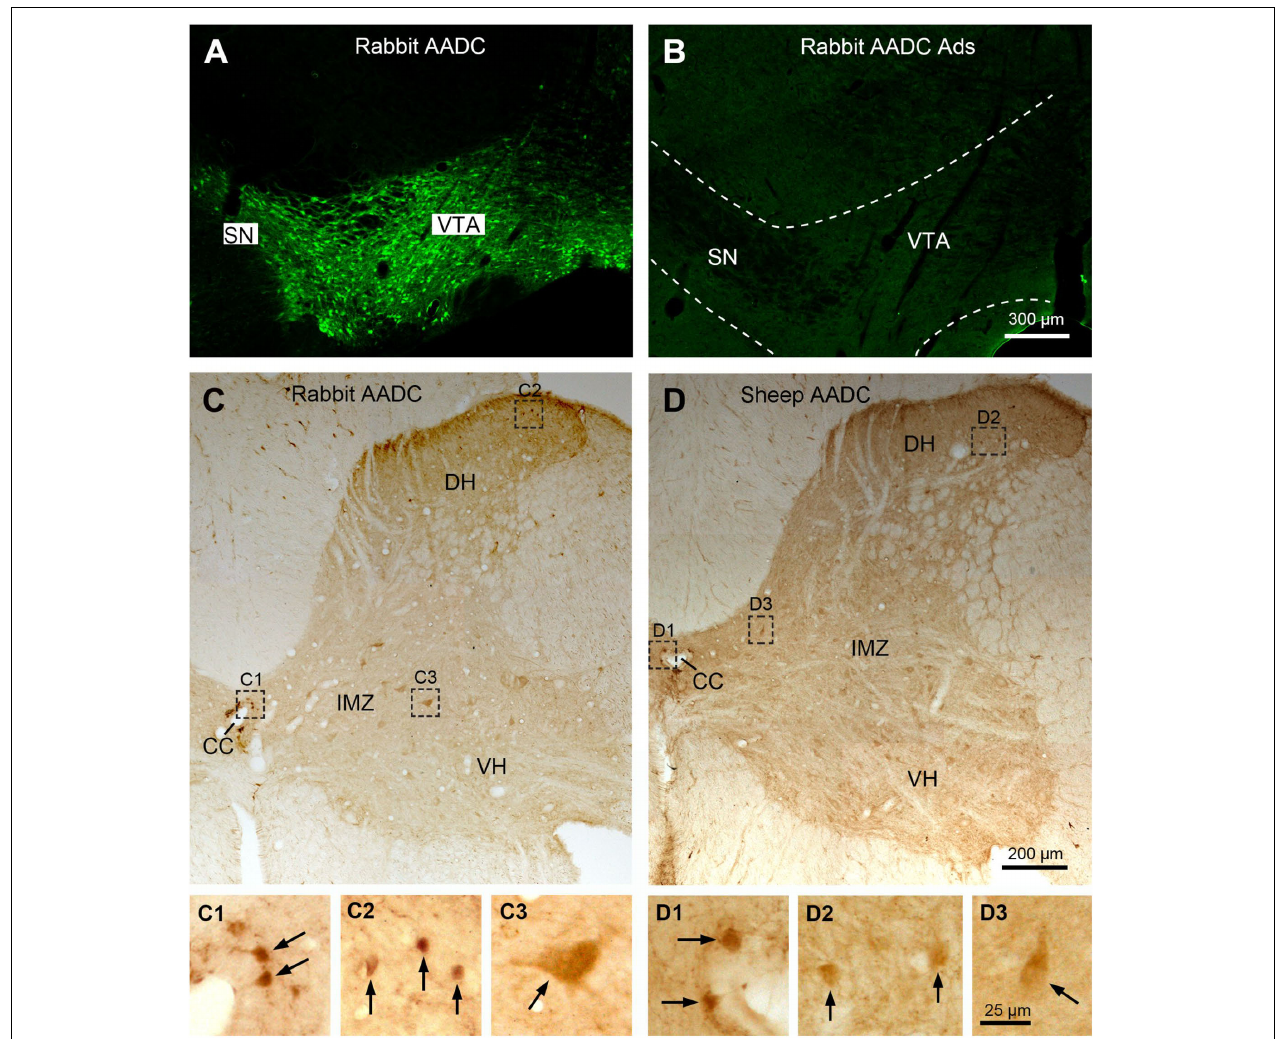
FIGURE 1 | Specificity control of Aromatic L -amino acid decarboxylase (AADC) antibodies. (A) Clearly immunolabeled cell bodies were seen in the substantia nigra (SN) and ventral tegmental area (VTA) in the midbrain when the sections were immunostained with rabbit AADC antibody. (B) When control staining was performed with the antibody pre-adsorbed (Ads) with whole long AADC recombinant proteins the specific AADC immunolabeling became absent in the midbrain. (C,D ) Rabbit and sheep AADC antibodies produced a similar immnuolabeling pattern in the spinal cord. (C,D) were from adjacent sections from C6 segment. (C1–C3) and (D1–D3) are enlargements of the areas demarcated with squares/rectangles in (C,D) showing the details of the AADC-labeled neurons (arrows) around the central canal (CC), in the dorsal horn (DH), and in the intermediate zone (IMZ). VH, ventral horn. Scale bar in (B) , valid for (A,B) , 300 µ m; in (D) , valid for (C) , (D) , 200 µ m; in (D3) , valid for (C1–D3) , 25 µ